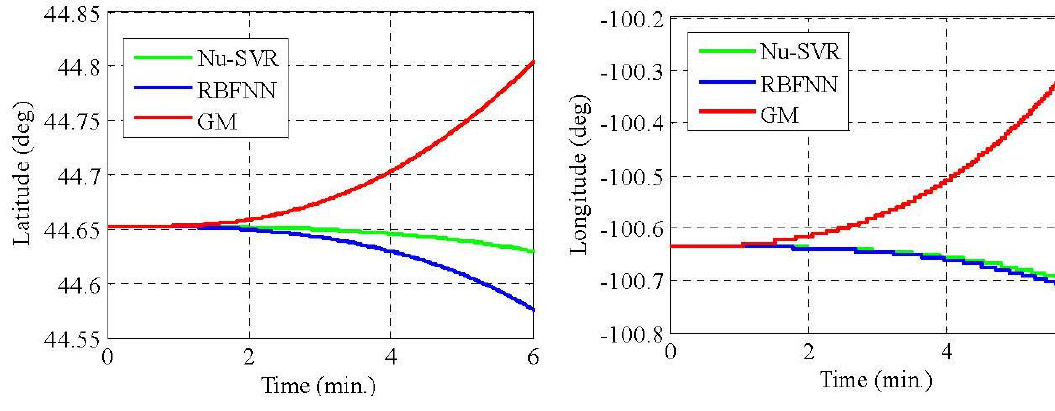
Figure 10. Velocity drifts by GM, RBFNN and Nu-SVR